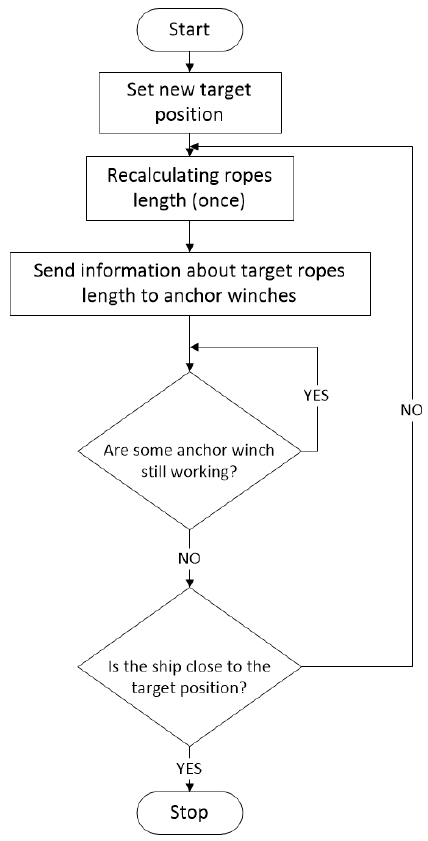
Figure 26. General control algorithm.